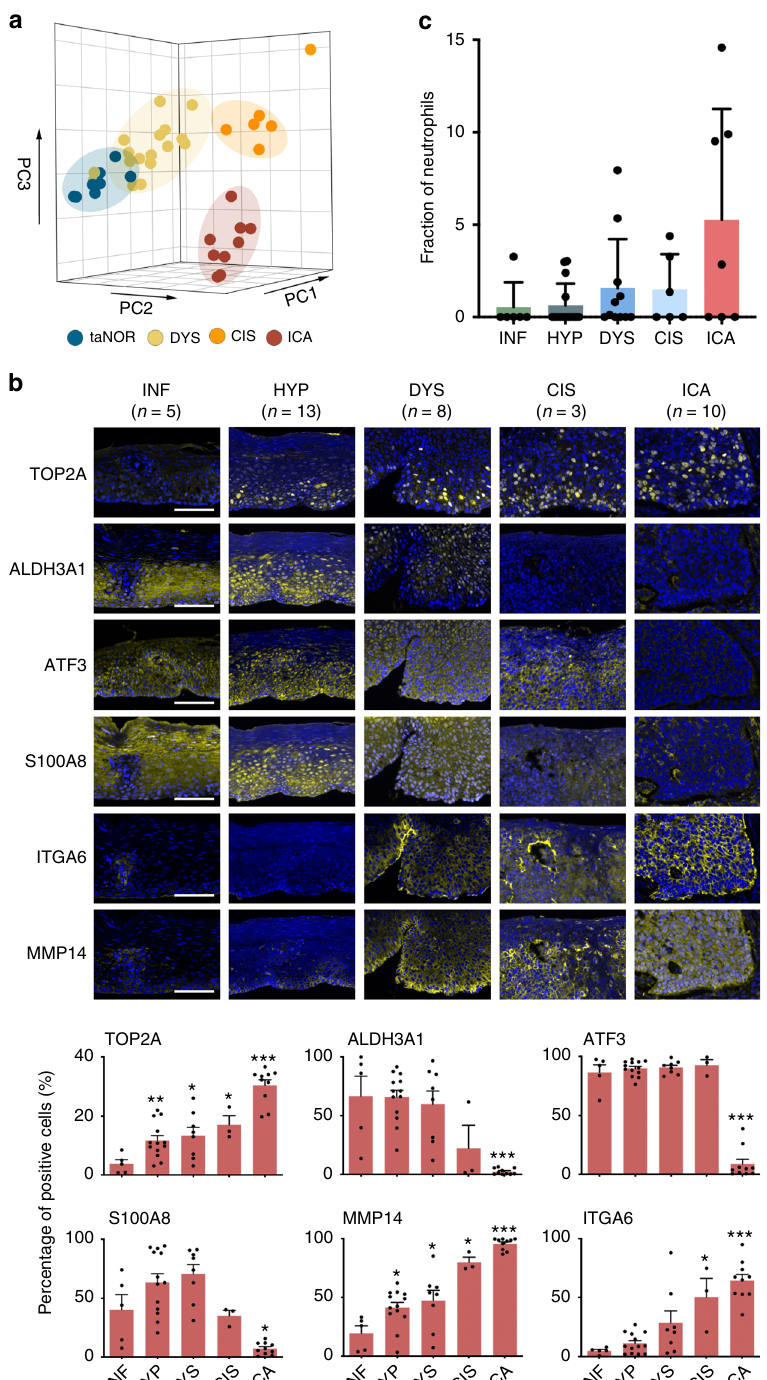
Fig. 7 Validation of expression features in human epithelial tissues with different lesions. a PCA plot of mini-bulk tissue RNA-seq on human esophageal tissues with different lesions as indicated by different colors and each dot represents a sample. b Immuno fl uorescence image (upper panel; scale bar, 100 μ m) and quanti fi cation of selected gene expression levels (lower panel) for human epithelia tissue samples with different lesions. Independent samples from stage INF to ICA are n = 5, 13, 8, 3, and 10, respectively. Data represent mean ± S.E.M. * P < 0.05, ** P < 0.01, *** P < 0.001, **** P < 0.0001 for two- sided Wilcoxon rank-sum test, compared with stage INF. P -values for TOP2A: 0.0098 (HYP), 0.0295 (DYS), 0.0357 (CIS), 0.0007 (ICA); ALDH3A1: 0.0007 (ICA); ATF3: 0.0007 (ICA); S100A8: 0.0127 (ICA); MMP14: 0.0140 (HYP), 0.0451 (DYS), 0.0357 (CIS), 0.0007 (ICA); ITGA6: 0.0357 (CIS), 0.0007 (ICA). c Proportion of neutrophils (relative to stage INF) in different precancerous and cancerous lesions based on bulk tissue RNA-seq using CIBERSORT. Each dot represents a sample, data represent mean ± S.D. P = 0.066, determined by two-sided Mantel – Haenszel chi-square test for linear trend. Independent patient samples from stage INF to ICA are n = 6, 15, 11, 6 and 7,